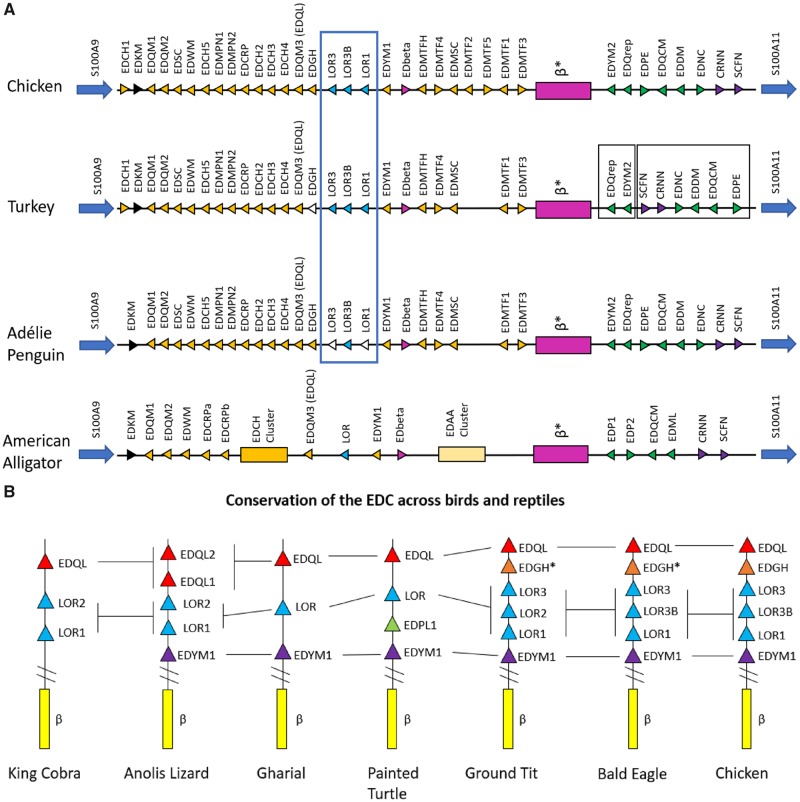
—Genomic organization of loricrin within the EDC of archosaurs. (A) Schematic overview of the conservation of the entire EDC of the chicken (G. gallus), turkey (Meleagris gallopavo), adélie penguin (Pygoscelis adeliae), and saltwater crocodile (C. porosus). Chicken EDC organization identical to that proposed by Strasser et al. (2014), with the exception of the identification of EDMTF5. Filled-in arrows with black outlines represent complete SEDC genes, arrows with white fills indicate incomplete genes. Gene number annotations LOR1, LOR2, LOR3 come from annotations of chicken loricrins by Strasser et al. (2014). Colors correspond to classifications by Strasser et al. (2014). (B) Schematic representation of the region of the EDC which contains loricrins between the conserved genes EDQL (formerly EDQM3) and the β-keratin gene cluster. The genes EDQL and EDYM1 are conserved across all species examined. EDGH sequences were identified in all avian species, however, the start codon from the chicken identified by Strasser et al. (2014) was not present in other bird species(*). The loricrin copy number varied across different groups of organisms, but in general squamates possessed 2, crocodilian and testudine species contained 1, and birds 3 loricrin genes. Arrow colors represent related genes. Parallel lines between EDYM1 and β-box indicate presence of variable number of lineage-specific EDC genes. King cobra EDC genes identified by Holthaus et al. (2016), anole lizard EDC genes identified by Strasser et al. (2014), and painted turtle EDC genes identified by Holthaus et al. (2015).